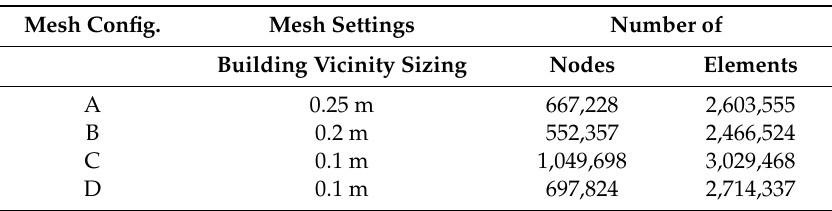
Table 4. Mesh setup for verification.